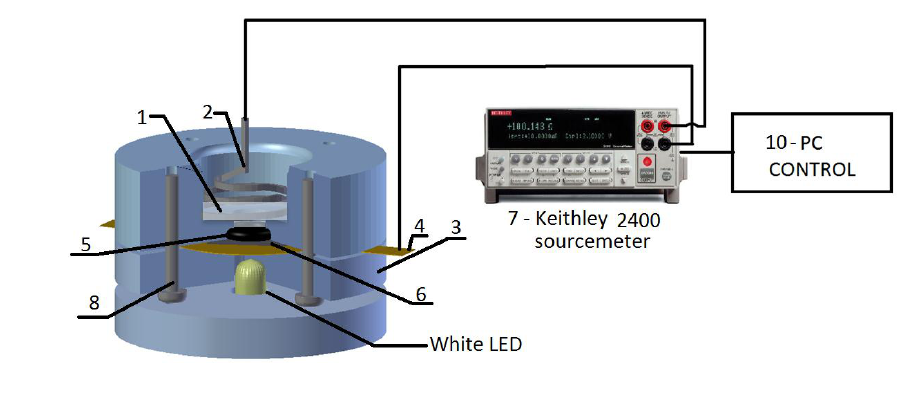
Figure 1. Diagram of the experimental setup: ( a ) cross-section view; ( b ) aside view of the electrochemical